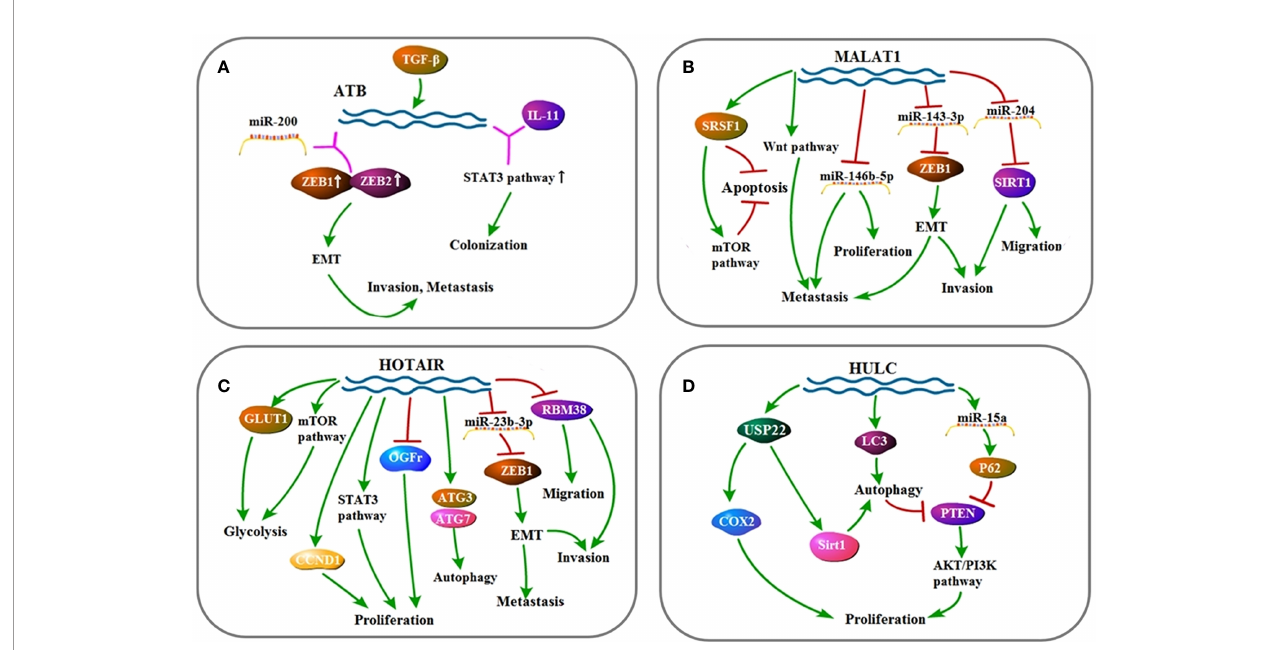
FIGURE 2 | (A) Signaling pathway of ATB : ATB affects cell invasion, metastasis, and colonization by up-regulating EMT and STAT3 pathway. (B) Signaling pathway of MALAT1 : MALAT1 affects cell invasion, metastasis, proliferation, migration, and apoptosis mainly through up-regulating EMT, Wnt pathway, STAT3 pathway, and mTOR pathway. (C) Signaling pathway of HOTAIR : HOTAIR affects cell invasion, migration, autophagy, proliferation, metastasis, and glycolysis by up-regulating EMT, mTOR pathway, and STAT3 pathway. (D) Signaling pathway of HULC : HULC affects cell proliferation and autophagy by up-regulating AKT/PI3K pathway.